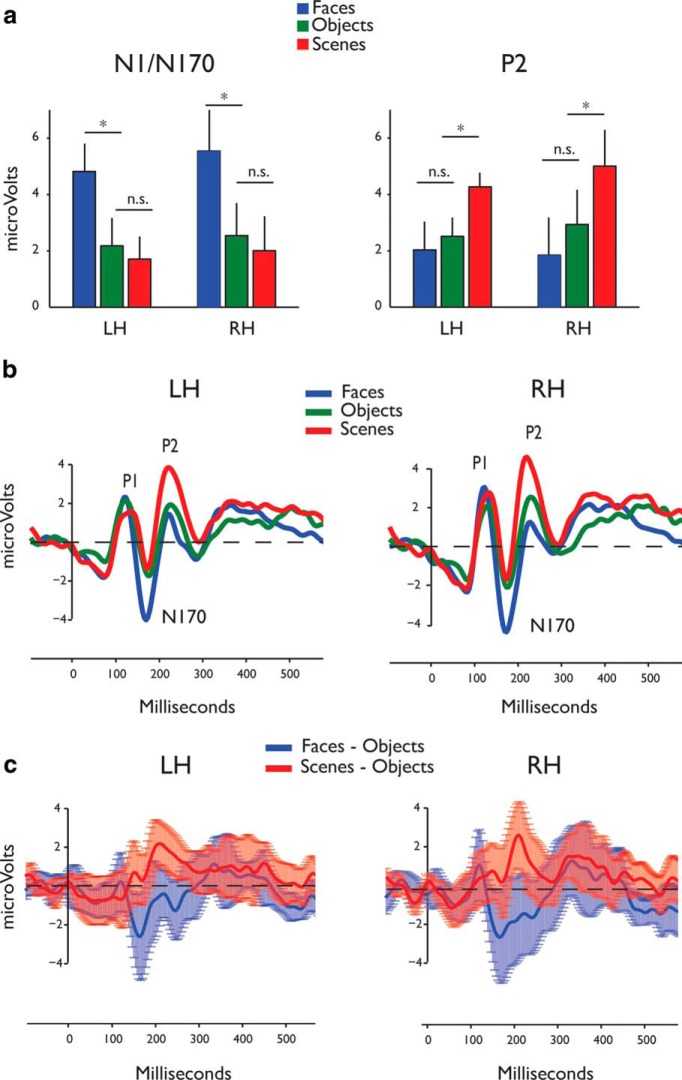
Experiment 1 results. a, Mean N1/170 and P2 peak amplitudes (left and right column, respectively) in response to scenes (red), faces (blue), and objects (green; peak amplitudes are plotted separately for each hemisphere, for the posterior lateral electrode sites. Error bars indicate the SEM. Significant differences (p < 0.05) between pairs of categories are denoted by asterisk. b, Group-averaged ERPs (n = 12) for the three categories (scenes in red, faces in blue, objects in green) for the left and right hemispheres (data are plotted for the posterior lateral sites). c, ERP difference waveforms depicting face sensitivity (blue, faces-objects) and scene sensitivity (red, scenes-objects) over time for the left and right hemispheres (data are plotted for the posterior lateral sites). The waveforms (solid lines) are presented with across-subjects 95% confidence intervals around them (light blue and red for face and scene sensitivity, respectively).